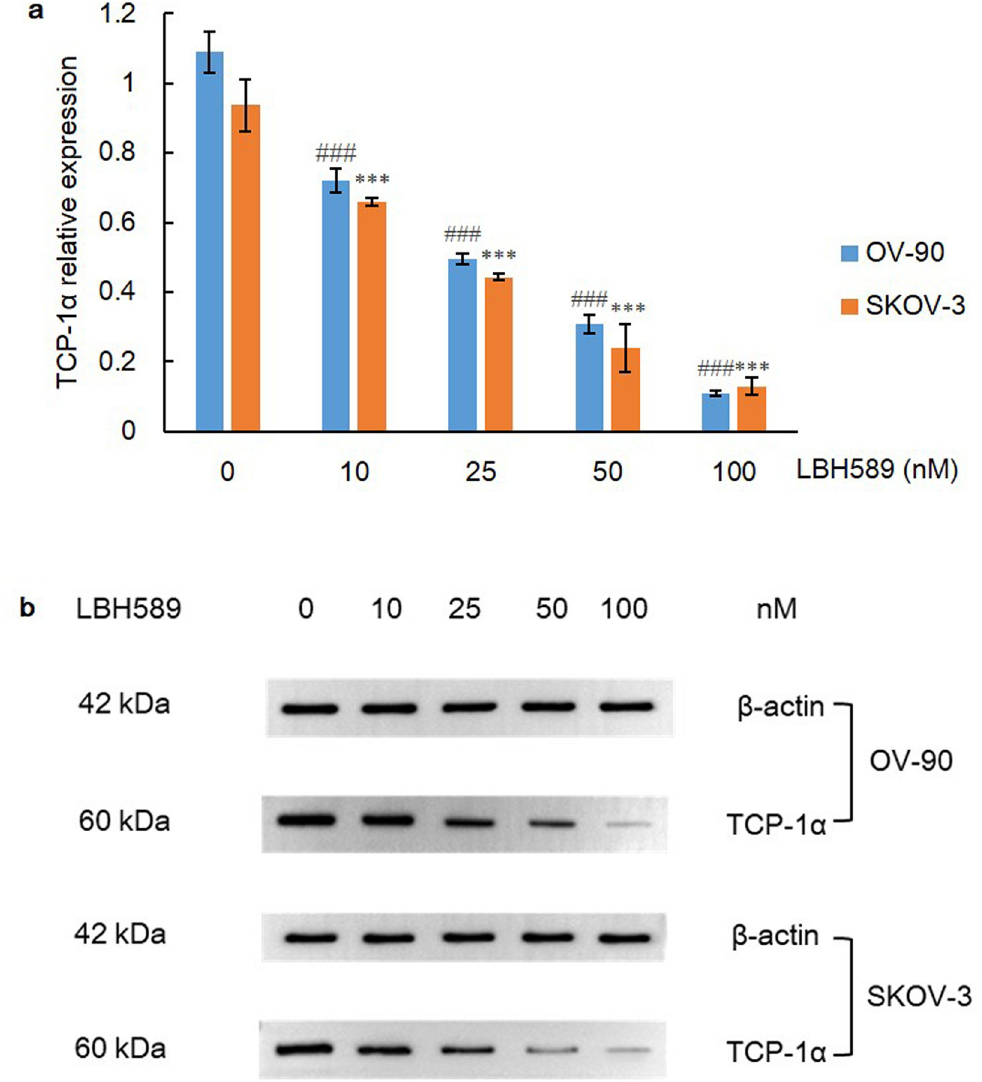
Fig 8. TCP-1 α expression after LBH589 treatment for 48 h. A) LBH589 suppresses expression of TCP-1 α in OV-90 and SKOV-3 cell lines. Data are shown as mean ± SD of at least three individual experiments. ( � P < 0.05, �� P < 0.01, ��� P < 0.001 vs. SKOV-3 control (0.1% DMSO); # P < 0.05, ## P < 0.01, ### P < 0.001 vs. OV-90 control (0.1% DMSO)). B) The expression of TCP-1 α was assessed by western blot analysis after LBH589 treatment for 48 h. The equal protein loading is shown by detection of β -actin. The figures show representative blots which were cropped from original